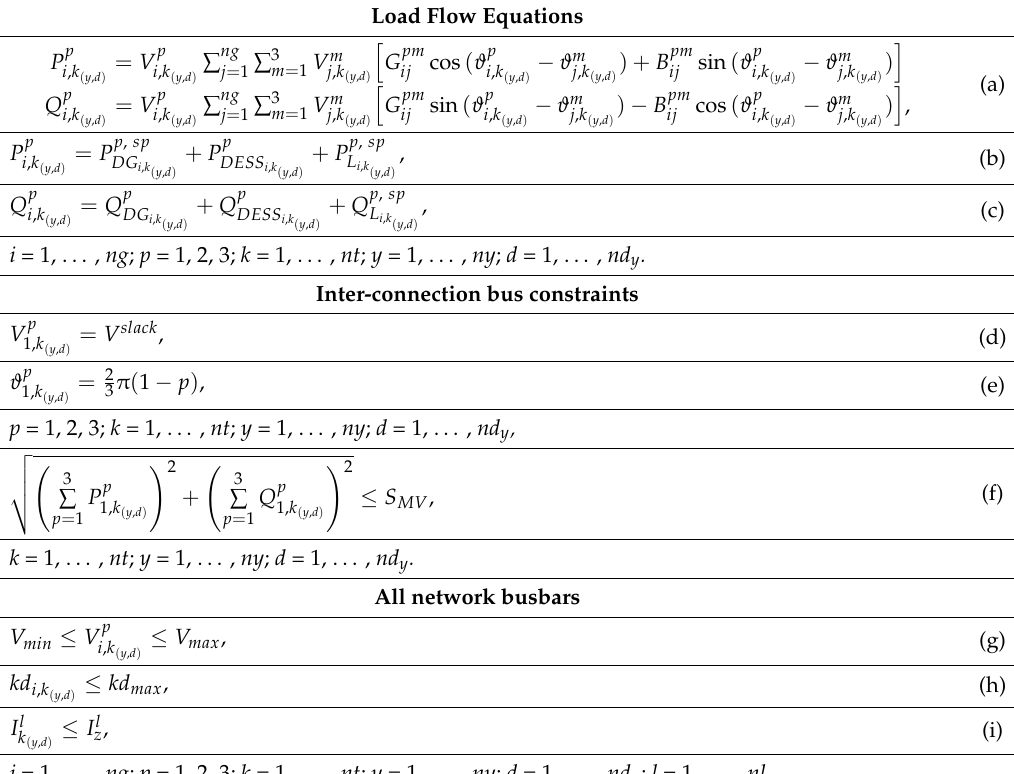
Table 4. Constraints on the network buses. Load Flow